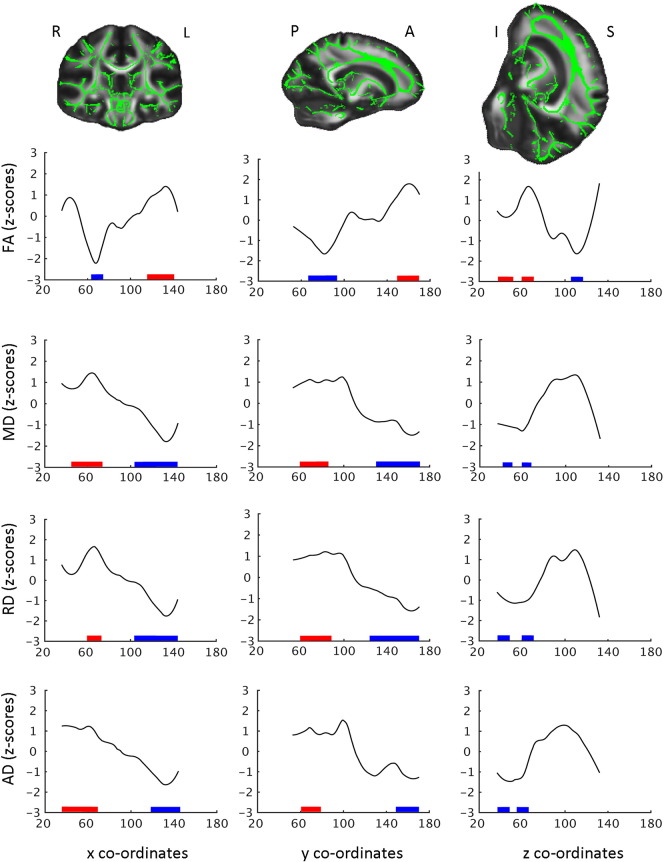
Slice-by-slice profiles of mean change for FA, MD, RD and AD.Slice-by-slice profiles of mean change for FA, MD, RD and AD, plotted for each coronal, sagittal and axial slice. X, Y and Z co-ordinates in MNI Space. Change for FA, MD, RD and AD are z-transformed change values. The FA skeleton (green) displayed on the FMRIB FA template in MNI space illustrate the principal gradients. L = left hemisphere, R = right hemisphere, P = posterior, A = anterior, I = inferior and S = superior. Significant (p < 0.05) differences between mean change and change for each slice are marked at the x axis. Red signifies greater positive change relative to mean change and blue signifies greater negative change relative to mean change. Slices marked are > 5 continues significant (p < 0.05) slices showing difference in change relative to mean change.